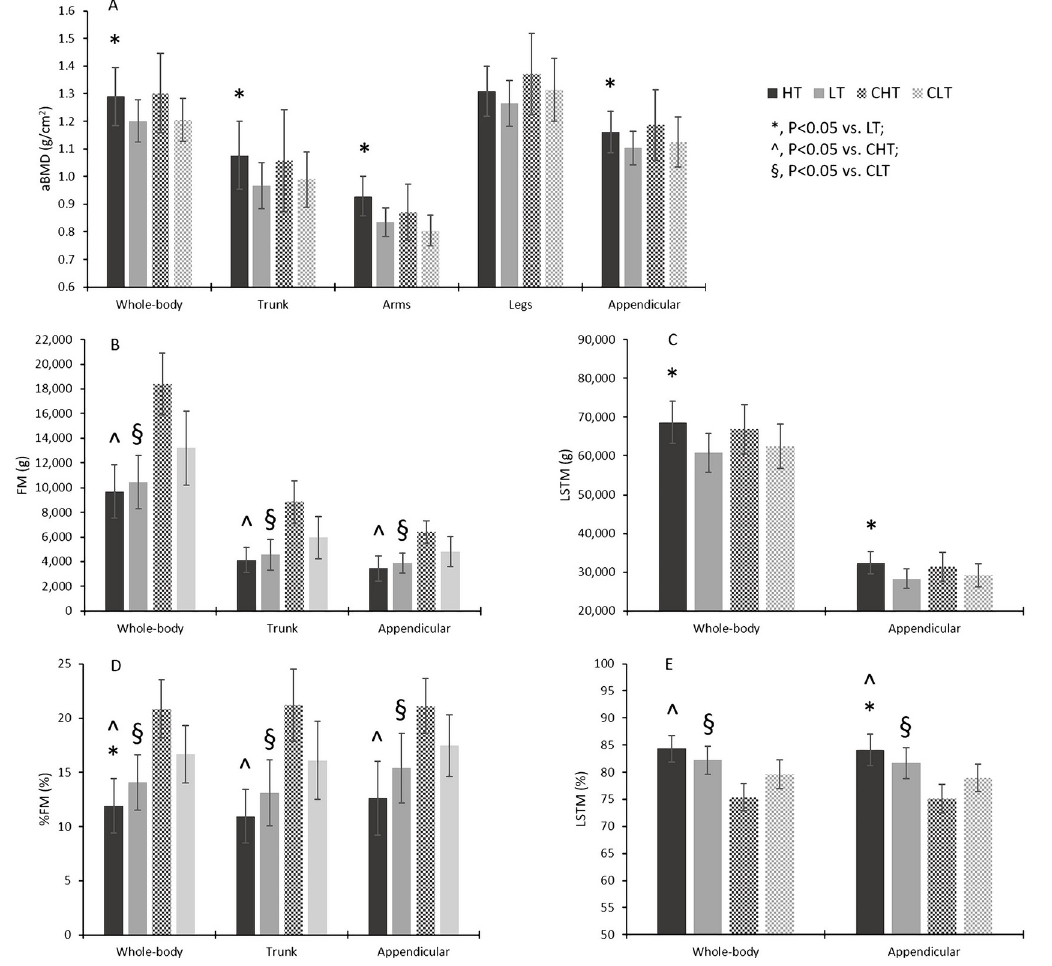
Fig 2. Whole-body and regional body composition in CF participants at higher (HT) and lower (LT) amounts of training, and in their age-matched and BMI-matched controls (CHT, CLT). aBMD, areal bone mineral density; FM, fat mass; LSTM, lean soft tissue